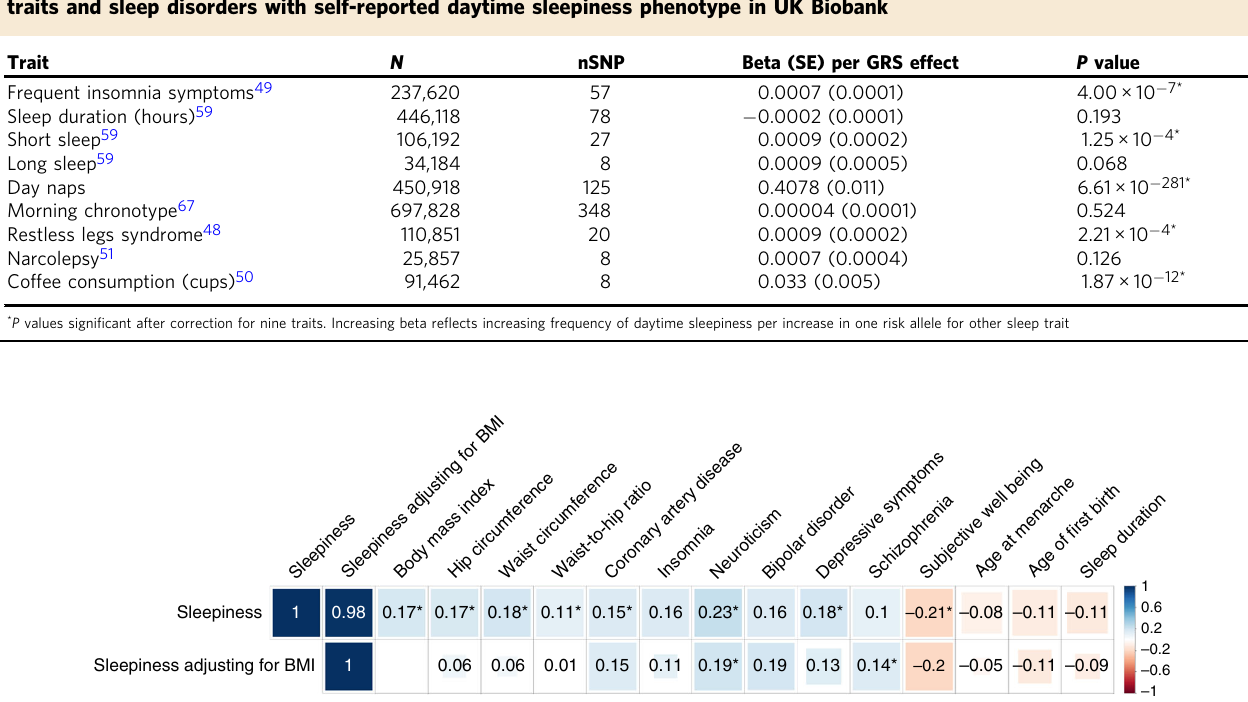
Fig. 3 Top signi fi cant genetic correlations ( r g ) between self-reported daytime sleepiness and published summary statistics of independent traits using genome-wide summary statistics using LD score regression (LDSC). Blue color indicates positive genetic correlation and red color indicates negative genetic correlation. Larger colored squares correspond to more signi fi cant P values, and asterisks indicate signi fi cant ( P < 2.2 × 10 − 4 ) genetic correlations after adjusting for multiple comparisons of 224 available traits. All genetic correlations in this report can be found in tabular form in Supplementary Data